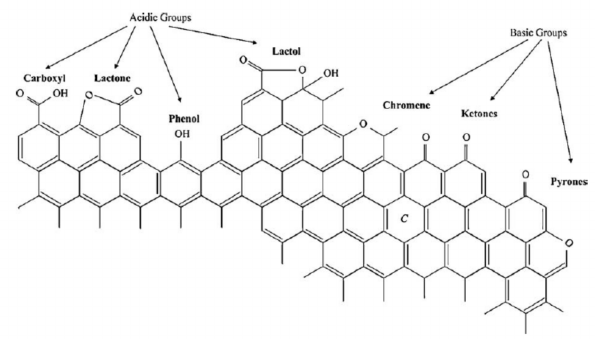
Figure 1. Acidic and basic surface functionalities on a carbon basal plane. Reprinted with permission from [44]. Copyright 2004 Elsevier Ltd.